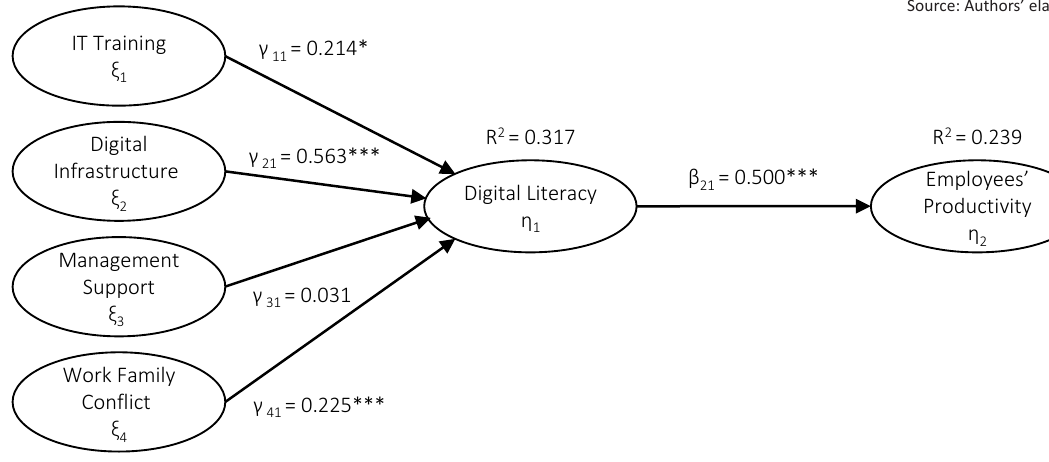
Figure 4. Structural model results